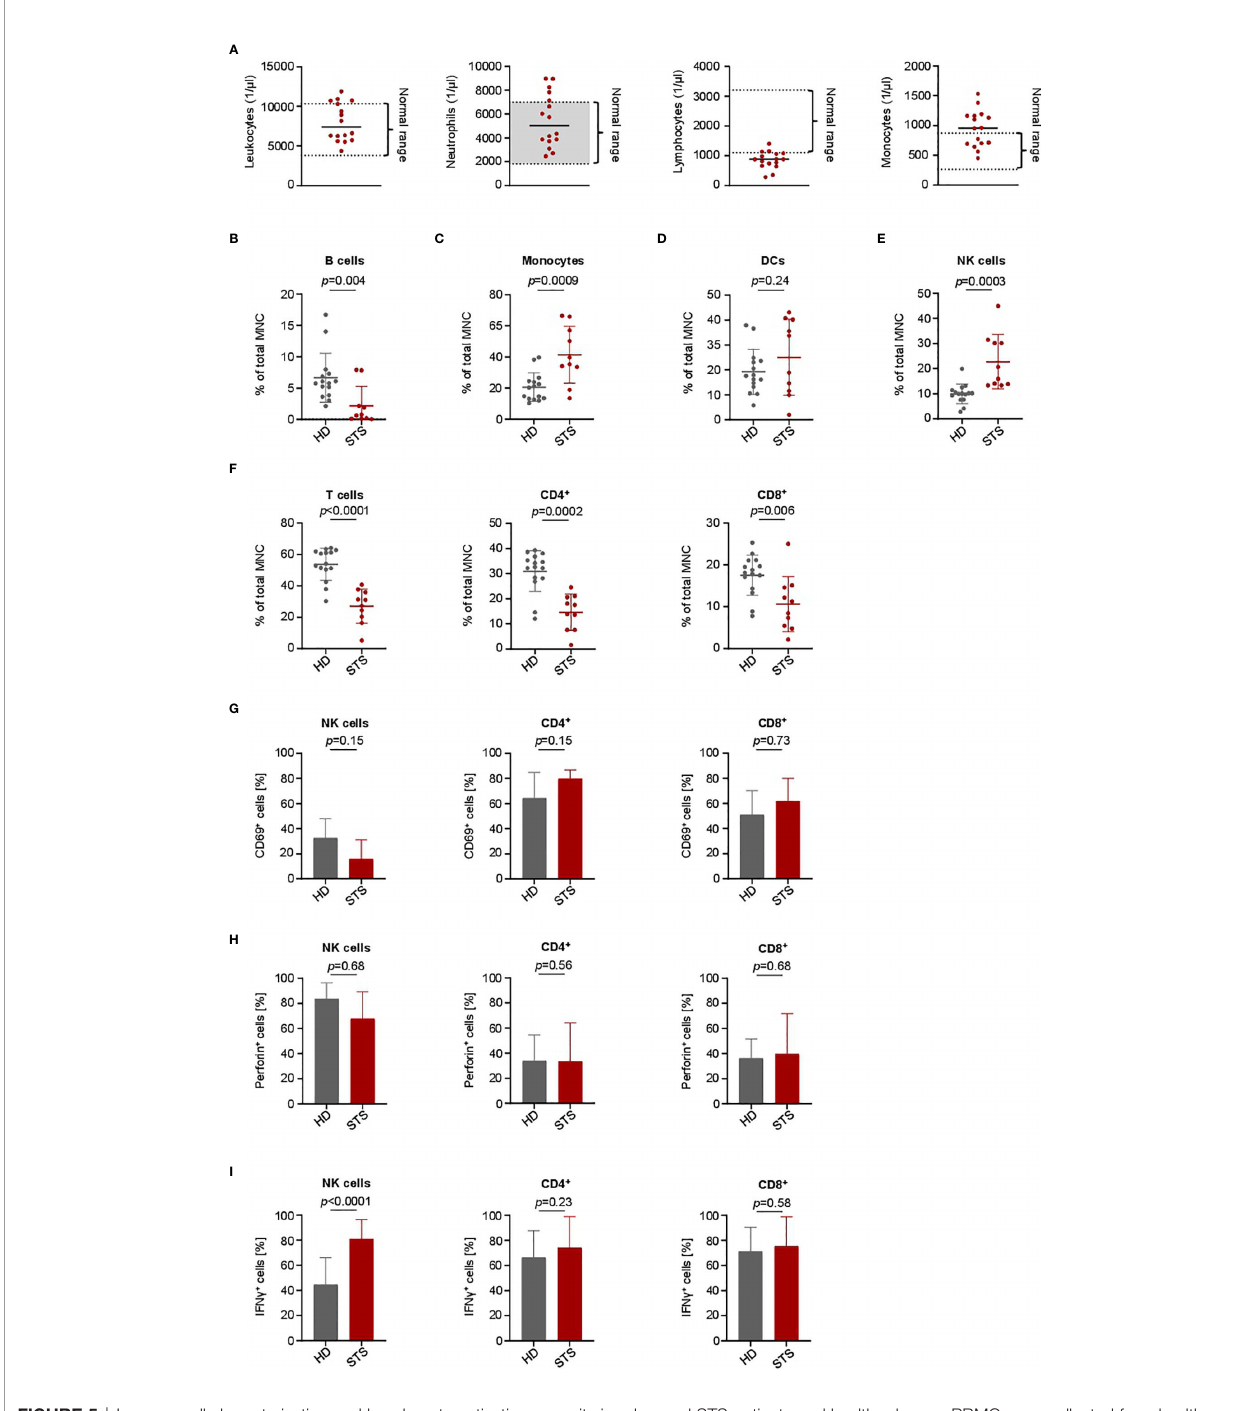
FIGURE 5 | Immune cell characterization and lymphocyte activation capacity in advanced STS patients and healthy donors. PBMC were collected from healthy donors (HD) and patients with advanced STS (STS). (A) Immune cell counts for leukocytes, neutrophils, lymphocytes and monocytes at time point of PBMC collection is shown (n=16). (B – F) Indicated cell types were identi fi ed by counterstaining of PBMC from HD (n=13) and from STS patients (n=10) for CD3, CD4, CD8, CD14, CD16, CD19, CD56 and HLA-DR and subsequently analyzed by fl ow cytometry and displayed as percentage of mononuclear cells (MNC). (G) To analyze the effector capacity of STS patient effector cells, bispeci fi c NKG2D-CD16/CD3 fusion proteins were immobilized to plastic as described in the methods section and incubated with PBMC of healthy donors (n=5) or sarcoma patients (n=4). Expression of CD69 as marker for activation was determined after 24 h using fl ow cytometry. Percentage of CD69 positive NK cells after treatment with NKG2D-16 and percentage of CD69 positive CD4 + and CD8 + T cells after treatment with NKG2D-CD3 are shown. (H, I) PBMC from HD (n=6) and STS patients (n=5) were cultured with sarcoma cells (SaOs, RD-ES and SW1353) and treated with NKG2D-CD16/CD3 (2.5 µg/ml) for 24 h. Intracellular Perforin (h) and IFN g (I) expression was analyzed by fl ow cytometry for CD4 + and CD8 + T cells and NK